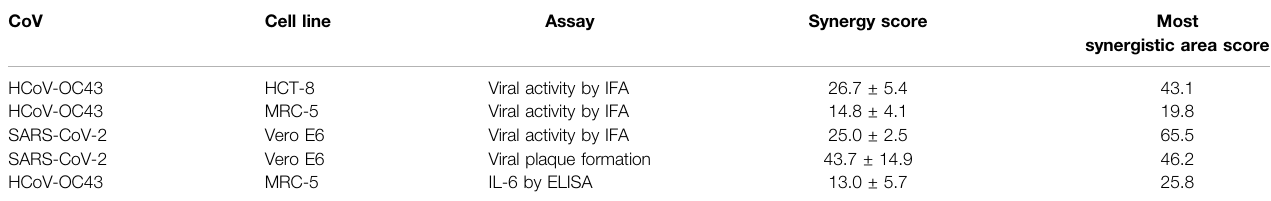
TABLE 2 | The synergistic inhibition of HCoV-OC43, SARS-CoV-2, and IL-6 production by remdesivir and cyclosporine. Synergy scores were calculated and analyzed by SynergyFinder, ZIP method. Shown synergy scores are AVE ± SD from three independent experiments. CoV Cell